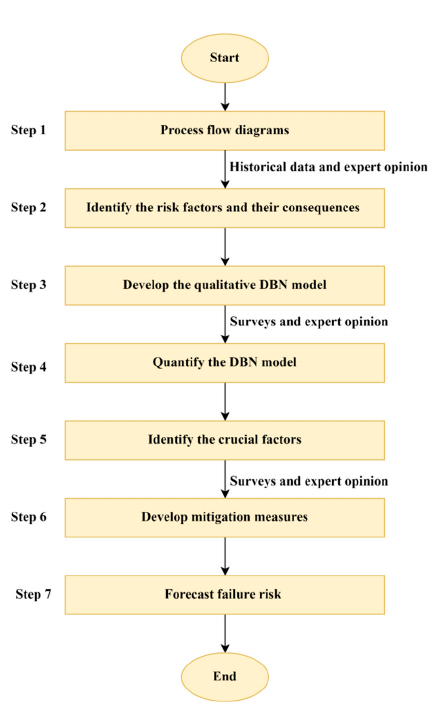
Figure 3. The framework of the proposed